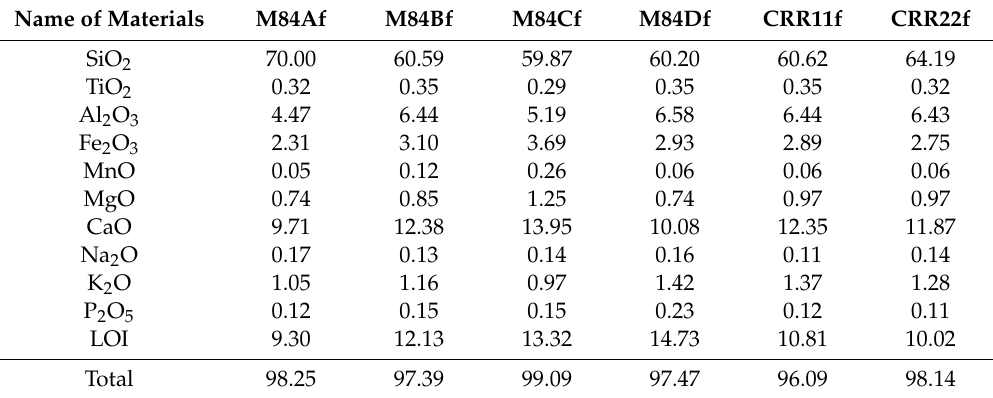
Table 6. Chemical composition of the di ff erent samples determined by XRF (%).